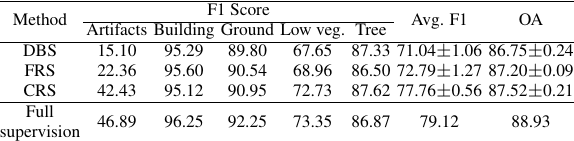
Table 7. Comparison of full and weak supervision schemes on the LASDU